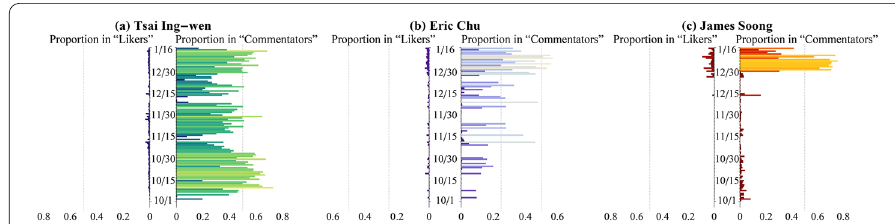
Figure 4 Proportions of overlapping users who have both liked and commented on the candidates’ posts among “Likers” and “Commentators”. The intermediate vertical axis is a timeline covering the whole period of the election. The bar on the left side of the timeline represents the daily proportion of overlapping users to users who have ever liked. The bar on the right side of the timeline represents the daily proportion of overlapping users to users who have ever commented. The number of overlapping users accounts for less than 1% of all the users who have “liked” on average, with the maximum proportions being 3.51%, 3.74%, and 9.25% for the three candidates. By contrast, the overlapping users constitute more than 37.16%, 14.90%, and 12.03% of all users who have commented, on average, for the three candidates, and the maximum ratios are 73.05%, 59.75%, and